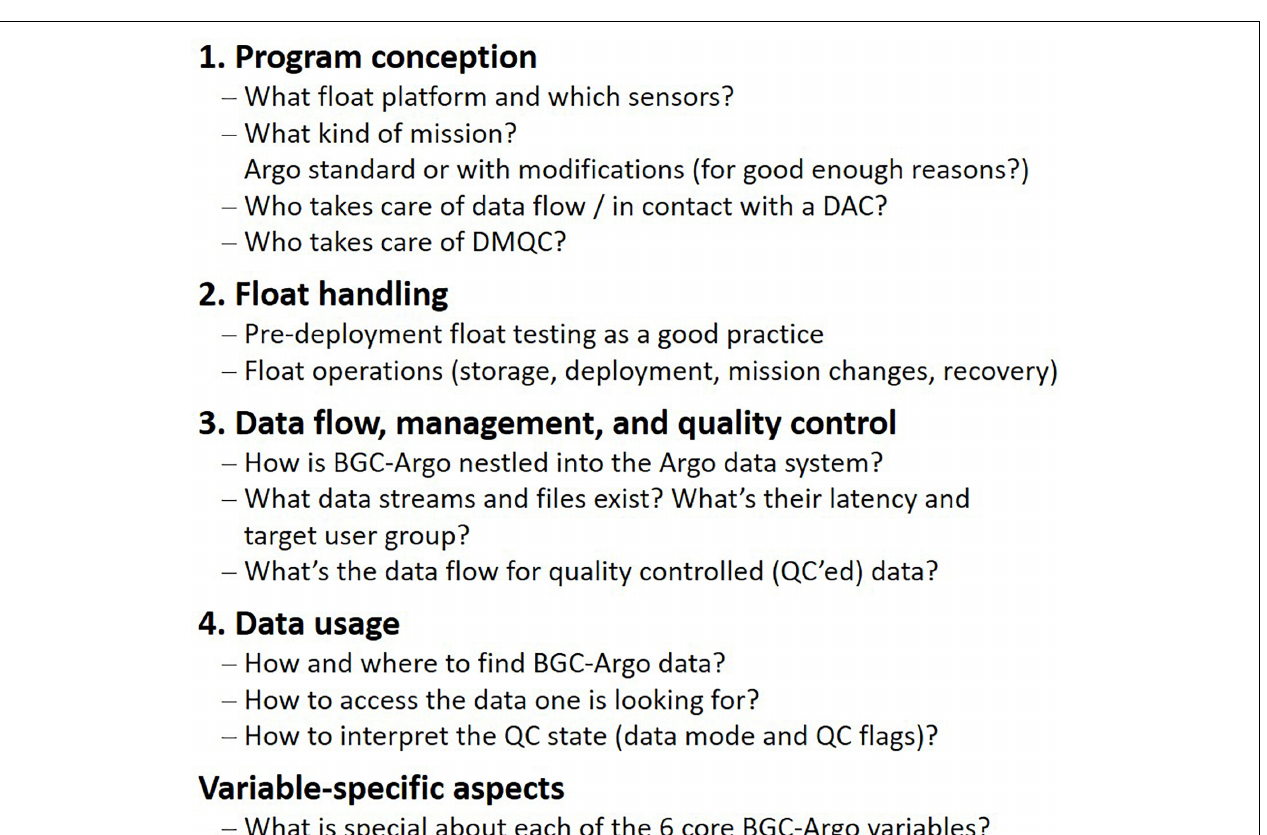
FIGURE 1 | Key points and questions of a “BGC-Argo float life”, from conception, float operations, data management and quality control to data usage.